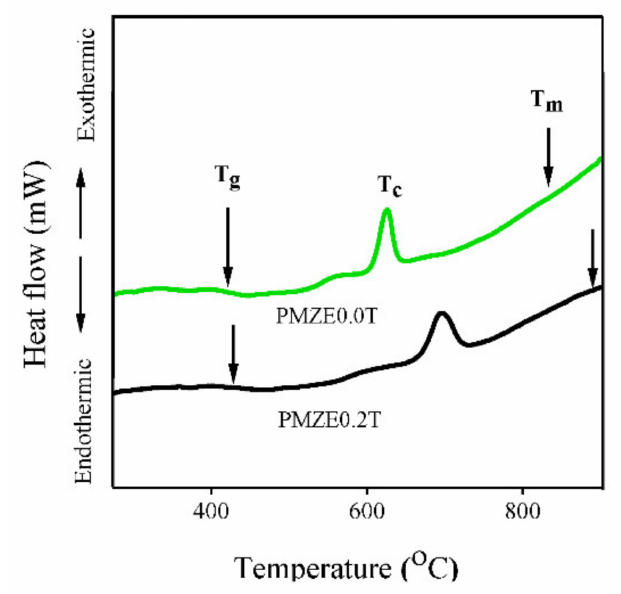
Figure 5. TA curve for PMZE0.0T and